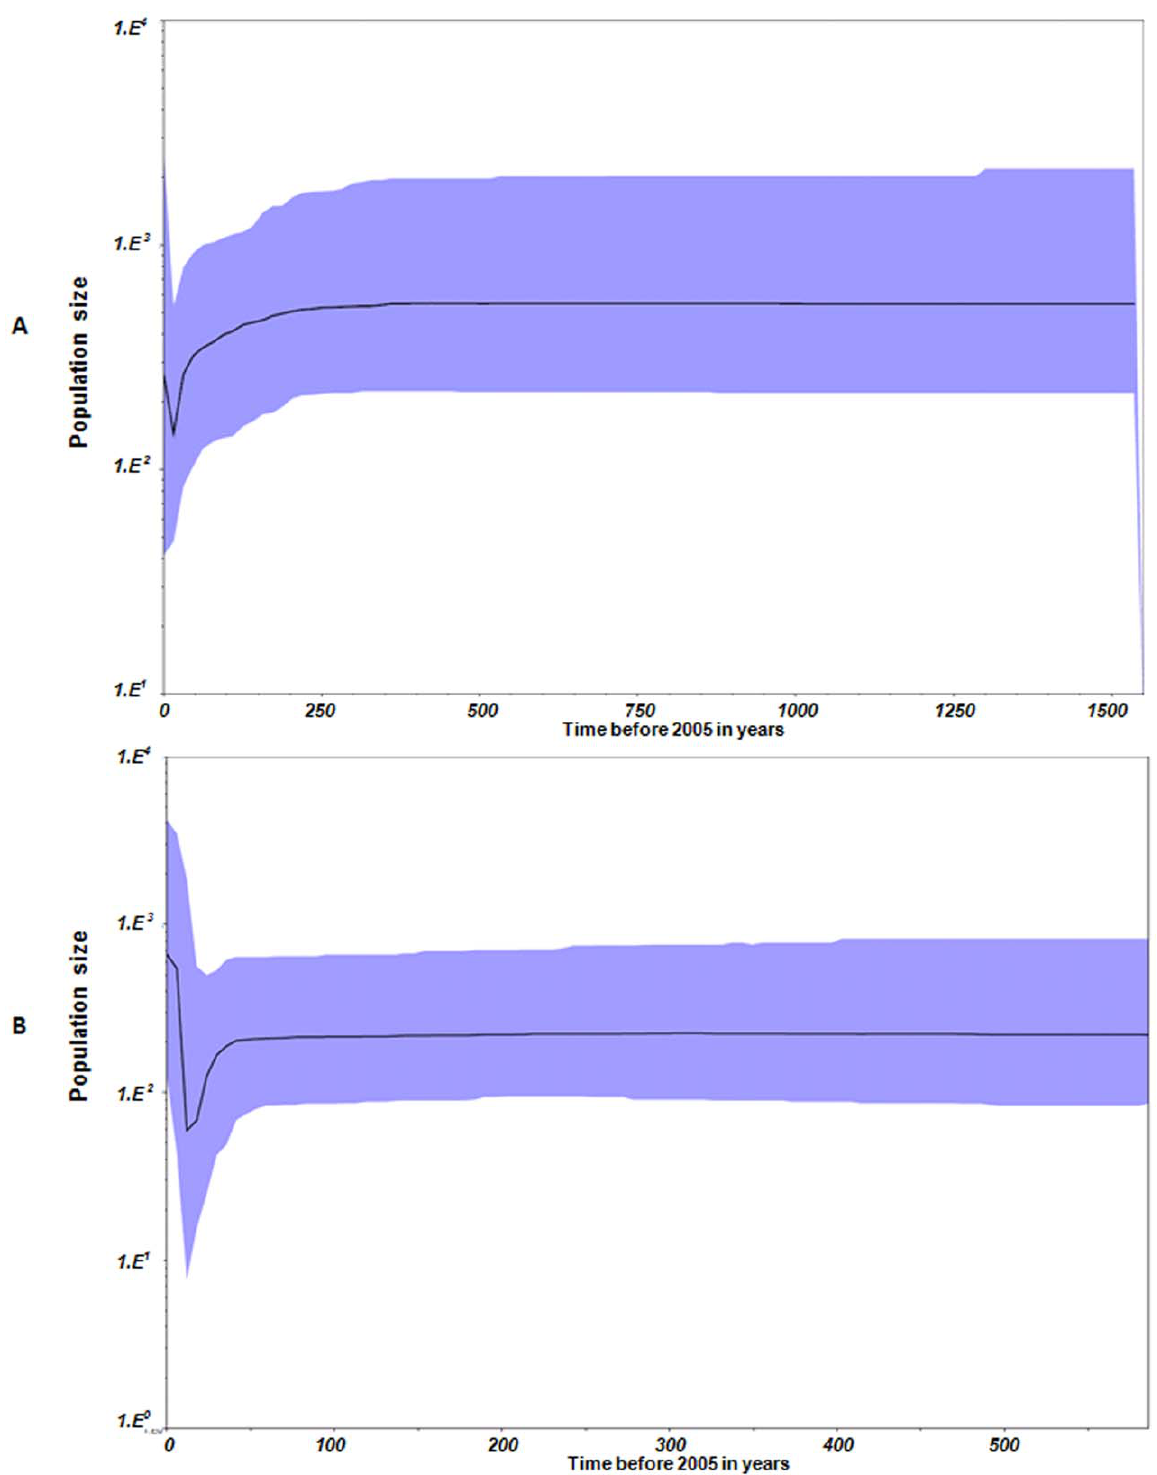
Figure 8. Bayesian skyline plots for segments 10 (A) and 12 (B) of LNV. The Bayesian skyline plots for both genes indicated that the virus had maintained relatively stable population sizes over the last 1553 years. However, in both segments 10 and 12, data suggested a temporary population decline during the late 1980s and early 1990s. Seg-12 data also suggest that a beginning of an expansion started in the late 1990s.